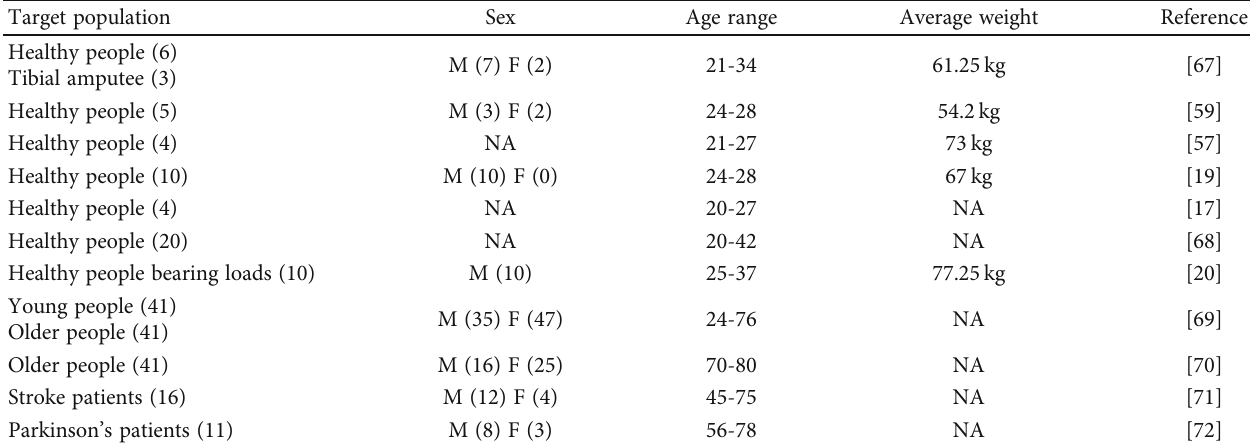
Table 1: Classi fi cation of the target population for the information